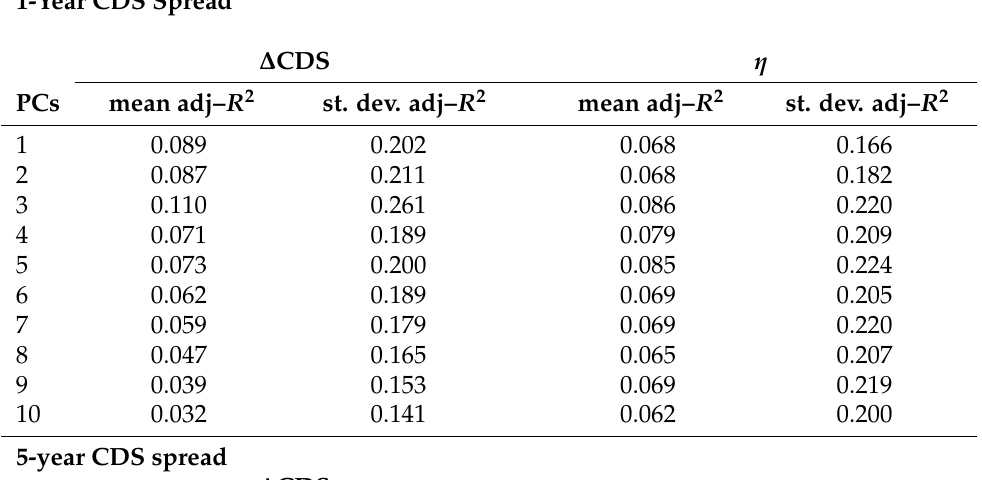
Table 14. Regression of both changes in CDS spreads (left columns) and residuals of (13) (right columns) onto an increasing set of principal components. Large average adjusted R 2 s in the first columns should would translate a significant impact of systematic factors on spread changes. This does not appear to be the case. The pattern of the average adjusted R 2 s obtained from regressing the PCs onto the residual of the ECM points should detect if some systematic factor could have been missed by (13). Mixed evidence is found regarding the first PC in the case of 5- and 10-year spreads.